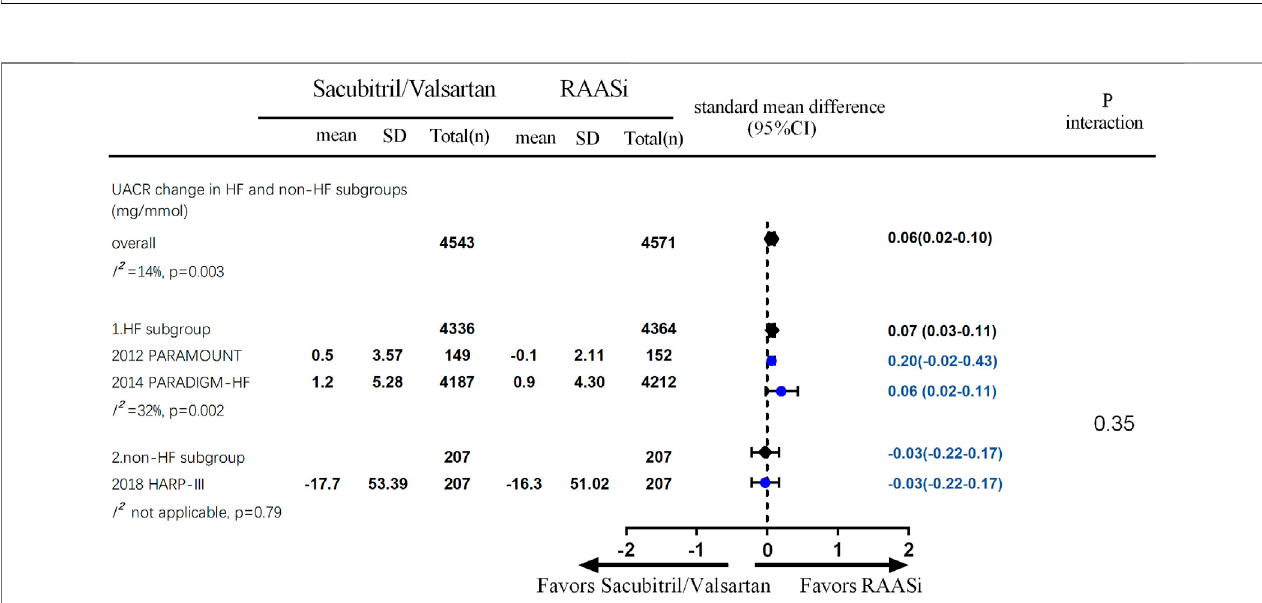
FIGURE 5 | UACR change during the follow-up — outcomes were from random-effect meta-analysis. RAASi, renin – angiotensin – aldosterone system inhibitor; UACR, urine albumin-to-creatinine ratio.